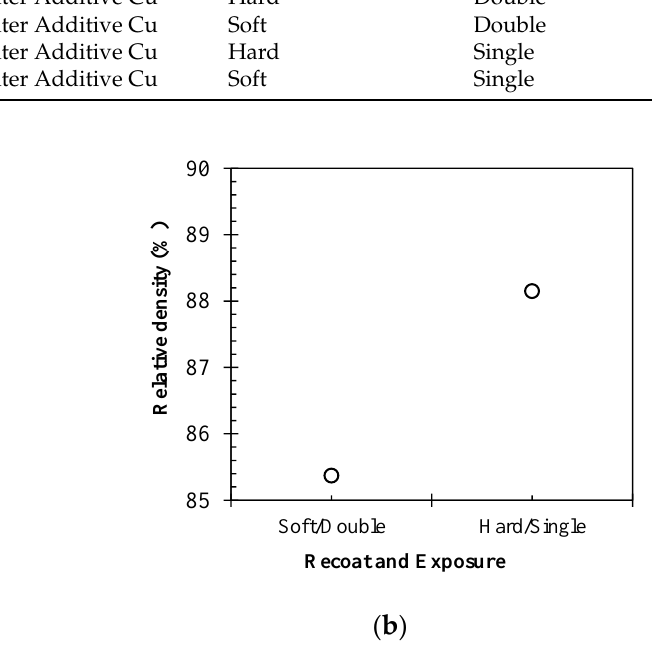
Figure 9. ( a ) IACS electrical conductivity performance for powder recoating and laser exposure parameters, ( b ) Relative densities obtained for powder recoating and laser exposure parameters.